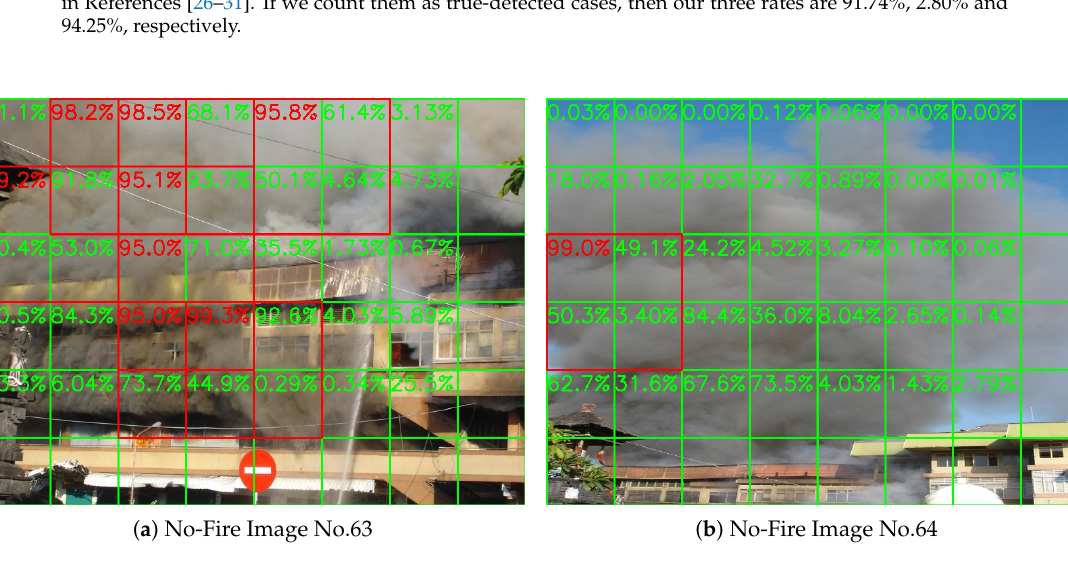
Figure 23. Two smoke images on the BoWFire no-fire test